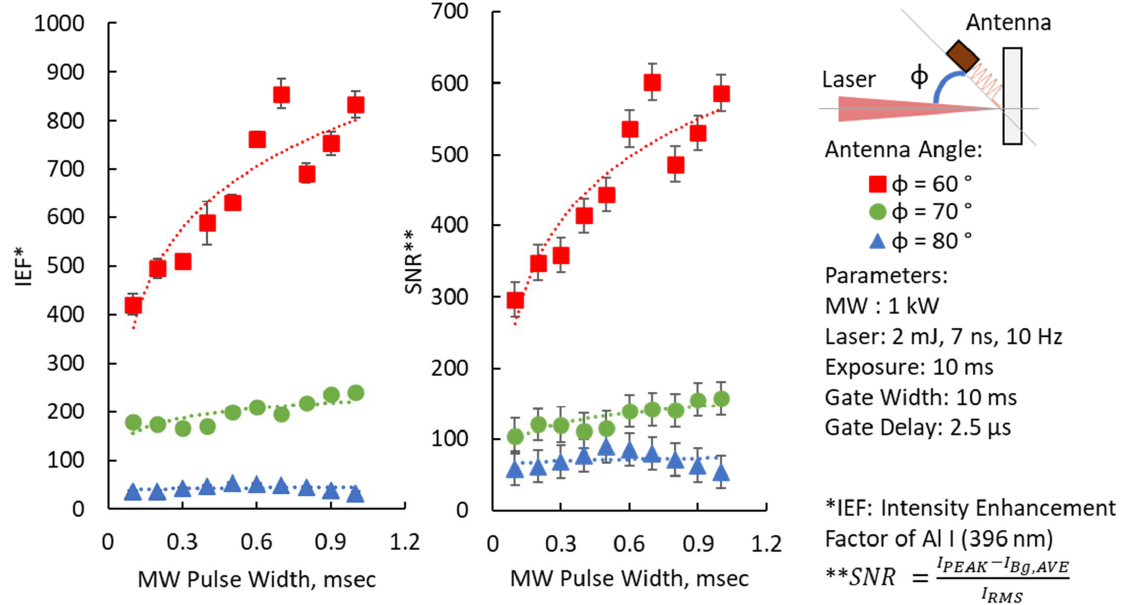
Figure 12. Enhancement factor and SNR for different antenna orientation angles from the laser beam propagation.